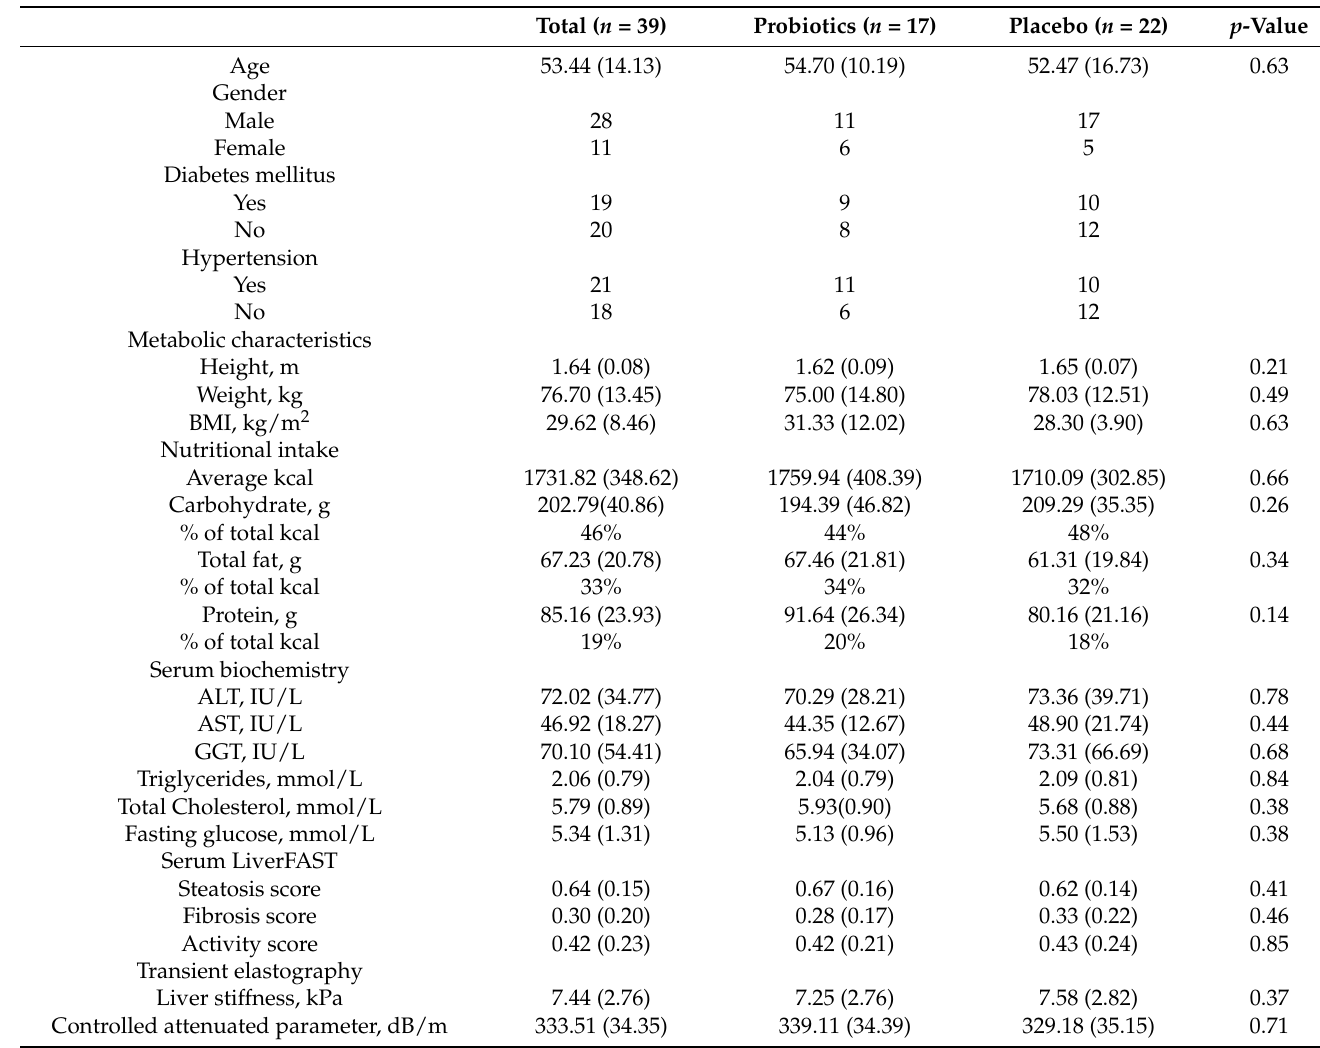
Table 2. Baseline characteristics of the studied patients. Values are presented as means (SD) for normally distributed